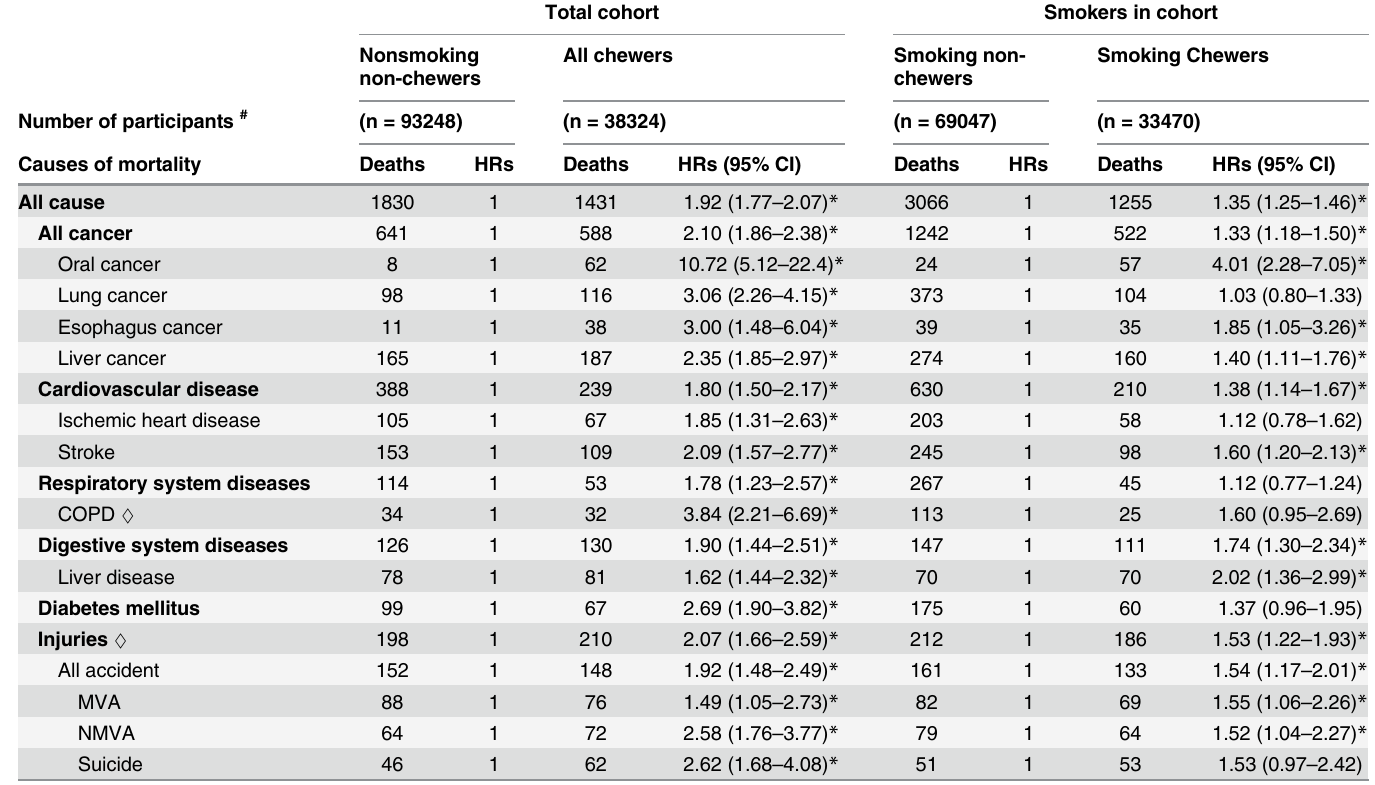
Table 2. Mortality risk of chewers in total cohort and among smokers in